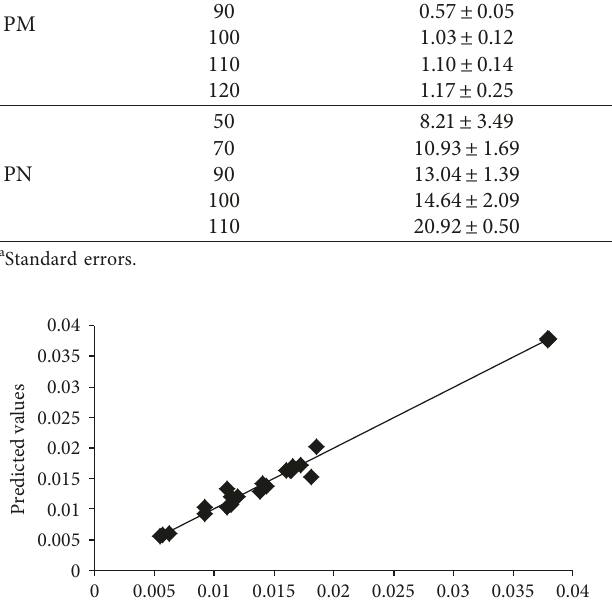
Table 2. The half-life at 50 ° C for PW, PCA, PS, PM, and PN were 6.27